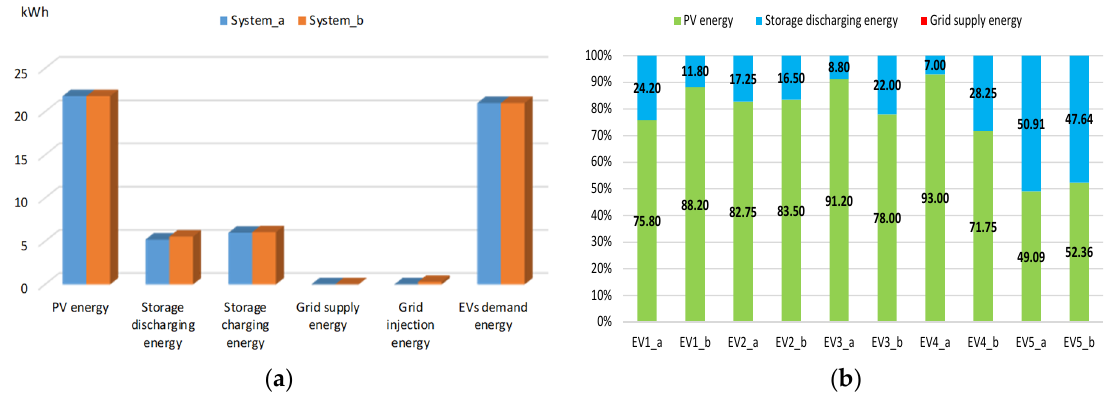
Figure 18. ( a ) Energy system distribution; ( b ) EVs energy distribution for Scenarios 2a and 2b.